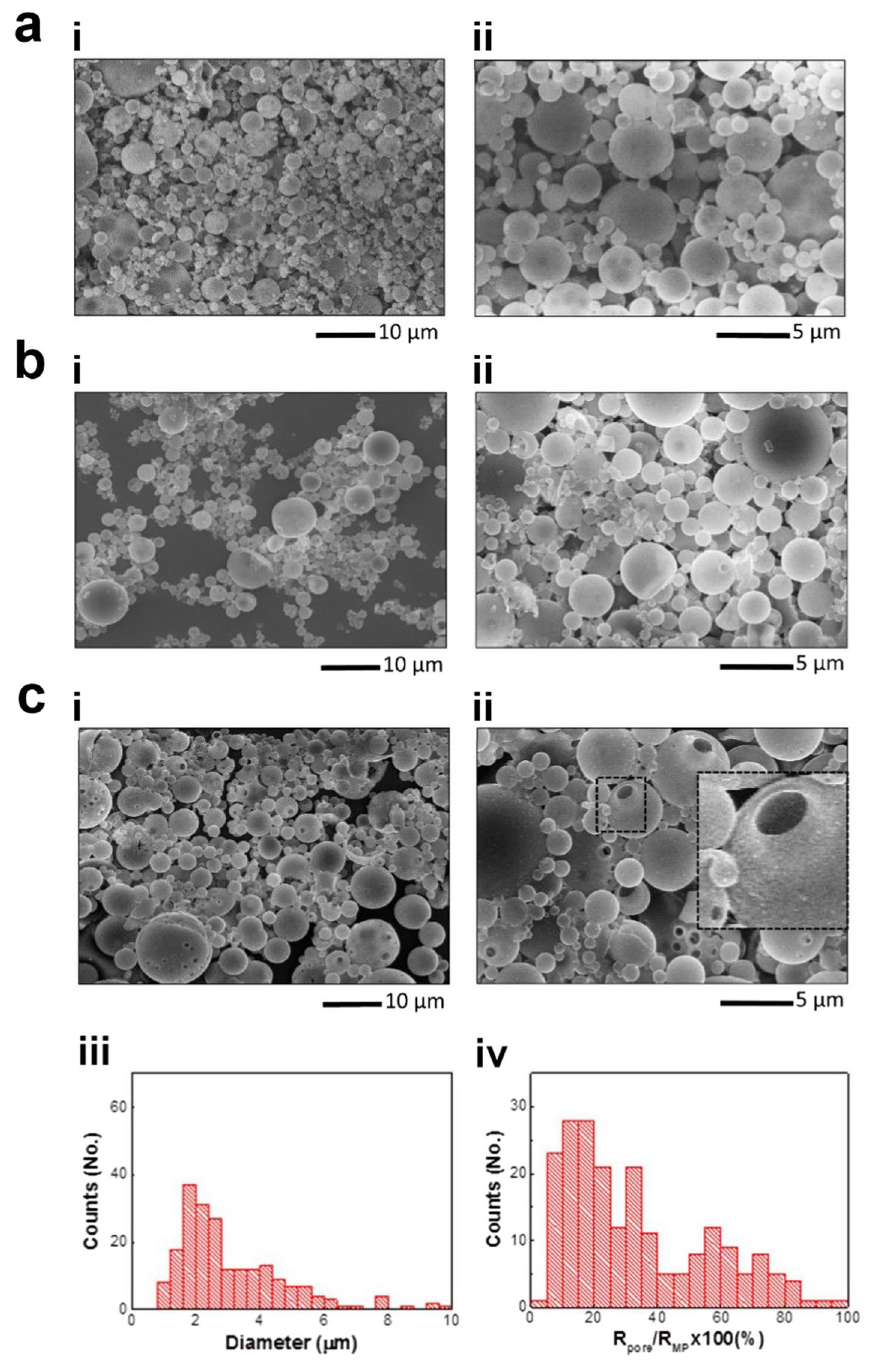
Figure 2. Pore closure and opening in response to pH. SEM images of MPs after pore closure by freeze-drying ( a ), and after being subjected to 2-hr incubation at pH 2.0 and 37 °C ( b ) (i: low mag. and ii: high mag.) ( c ) SEM images of MPs after being subjected to simulated GI tract conditions (2-hr incubation at pH 2.0, followed by 4-hr incubation at pH 7.1 at 37 °C, i: low mag. and ii: high mag.), i.e. after 4-hr incubation of the ( b ) sample at pH 7.1 and 37 °C (inset: × 3), and size distribution of MPs (iii) and Pore-to-MP size ratio (iv) analyzed from SEM images of MPs as shown in c (i, ii ) ( n =